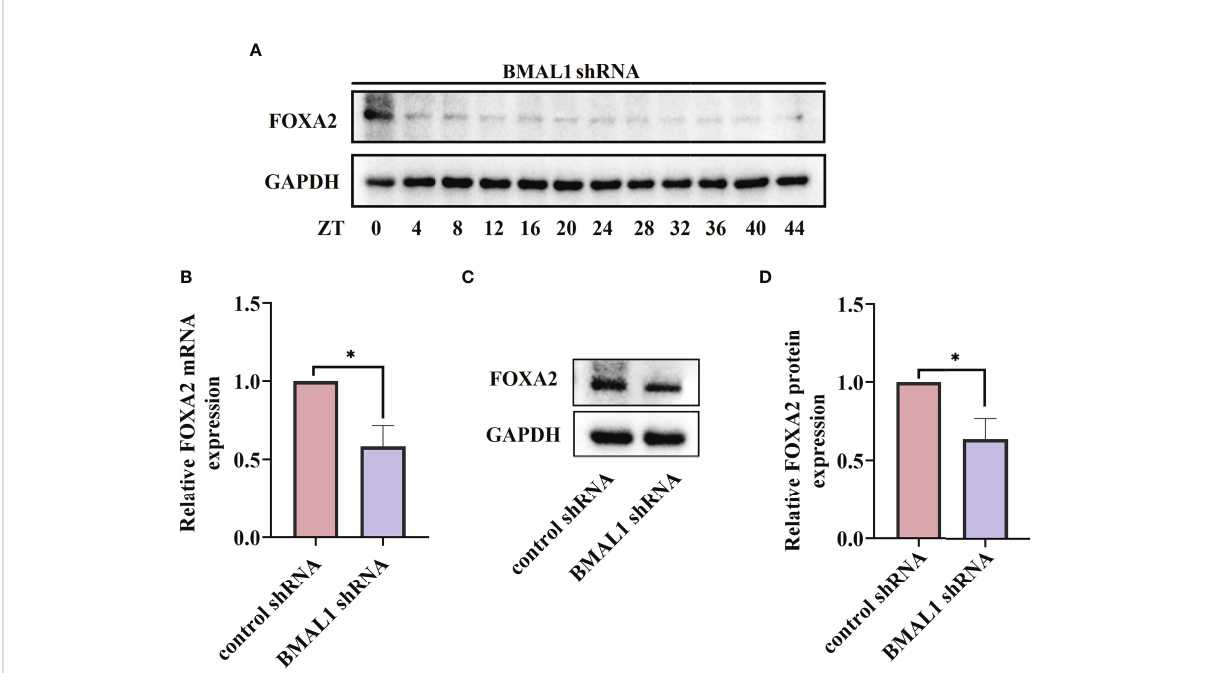
FIGURE 7 BMAL1 regulates the expression and rhythm fl uctuations of FOXA2 in 16HBE cells. (A) Western blot analysis of the protein levels of FOXA2 in BMAL1 shRNA cells in response to serum shock synchronisation. The mRNA (B) and protein (C) levels of FOXA2 expression in 16HBE cells with BMAL1 shRNA constructs and control shRNA by RT-qPCR and Western blot, respectively. ImageJ software was used to quantify FOXA2 bands (D) . by RT- qPCR and Western blot, respectively. ImageJ software was used to quantify BMAL1 bands (g). ZT, zeitgeber time. All data shown are representative data of one out of at least 3 independent experiments, * p < 0.05 compared with control shRNA cells, independent samples